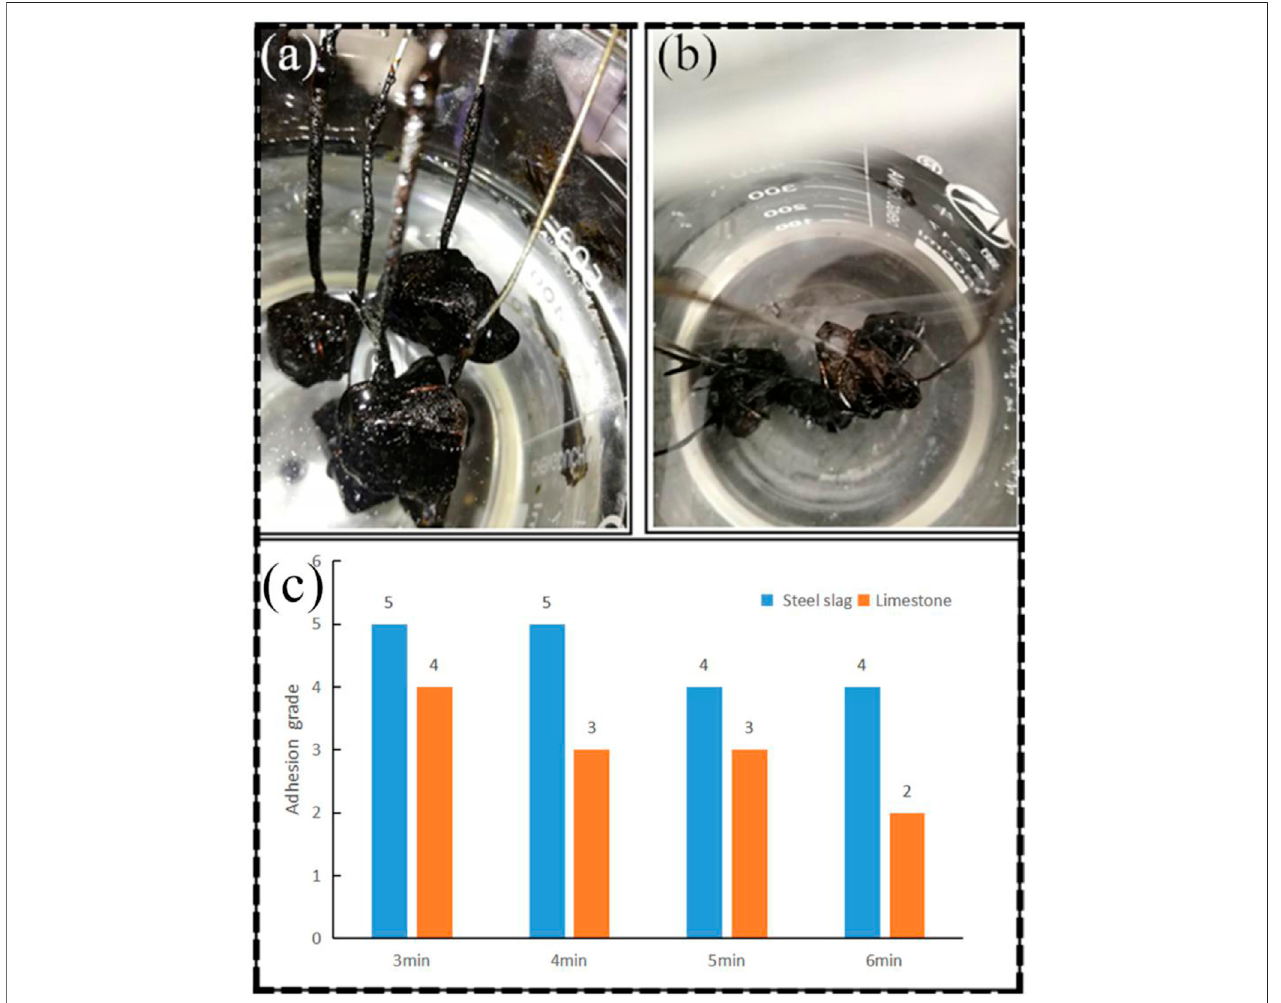
FIGURE 3| Adhesion tests between aggregates and asphalt: (A) steel slag aggregate adhesion test at 6 min; (B) limestone aggregate adhesion test at 6 min; and (C) results of aggregate adhesion.